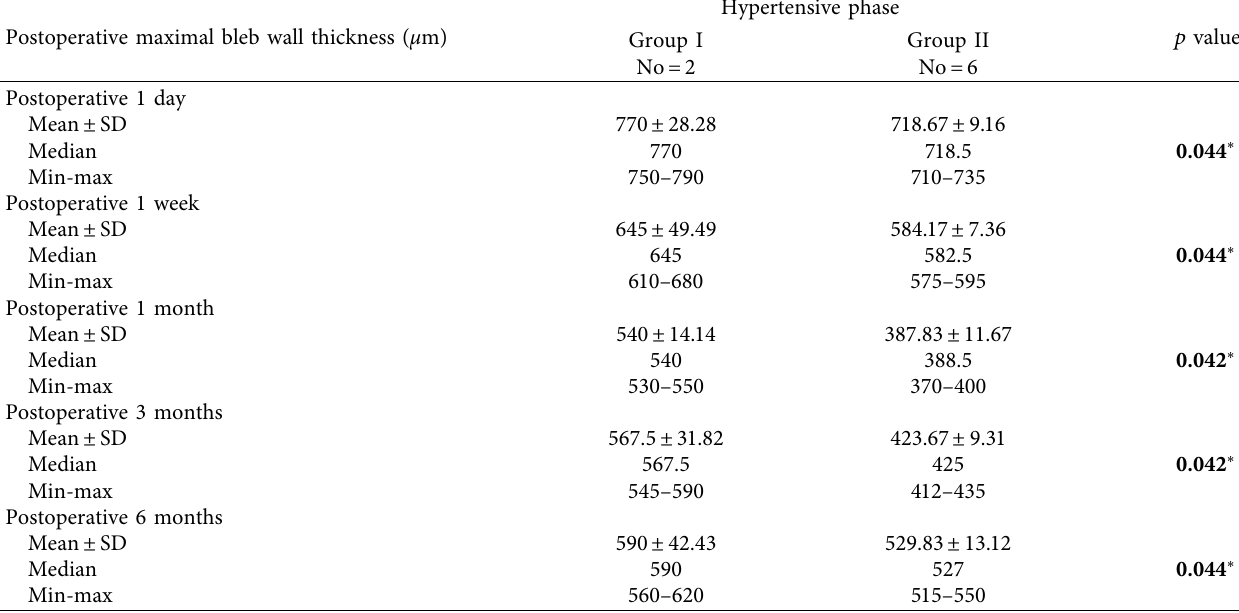
Table 6: Maximal bleb wall thickness in patients with hypertensive phase.